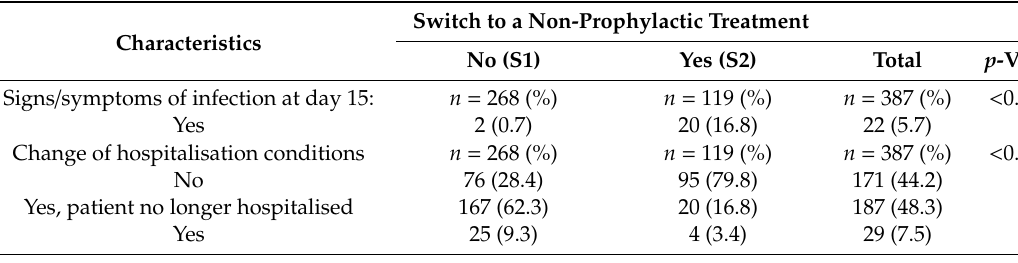
Table 6. Follow-up: patient status 15 days after AFP, neutropenia periods and